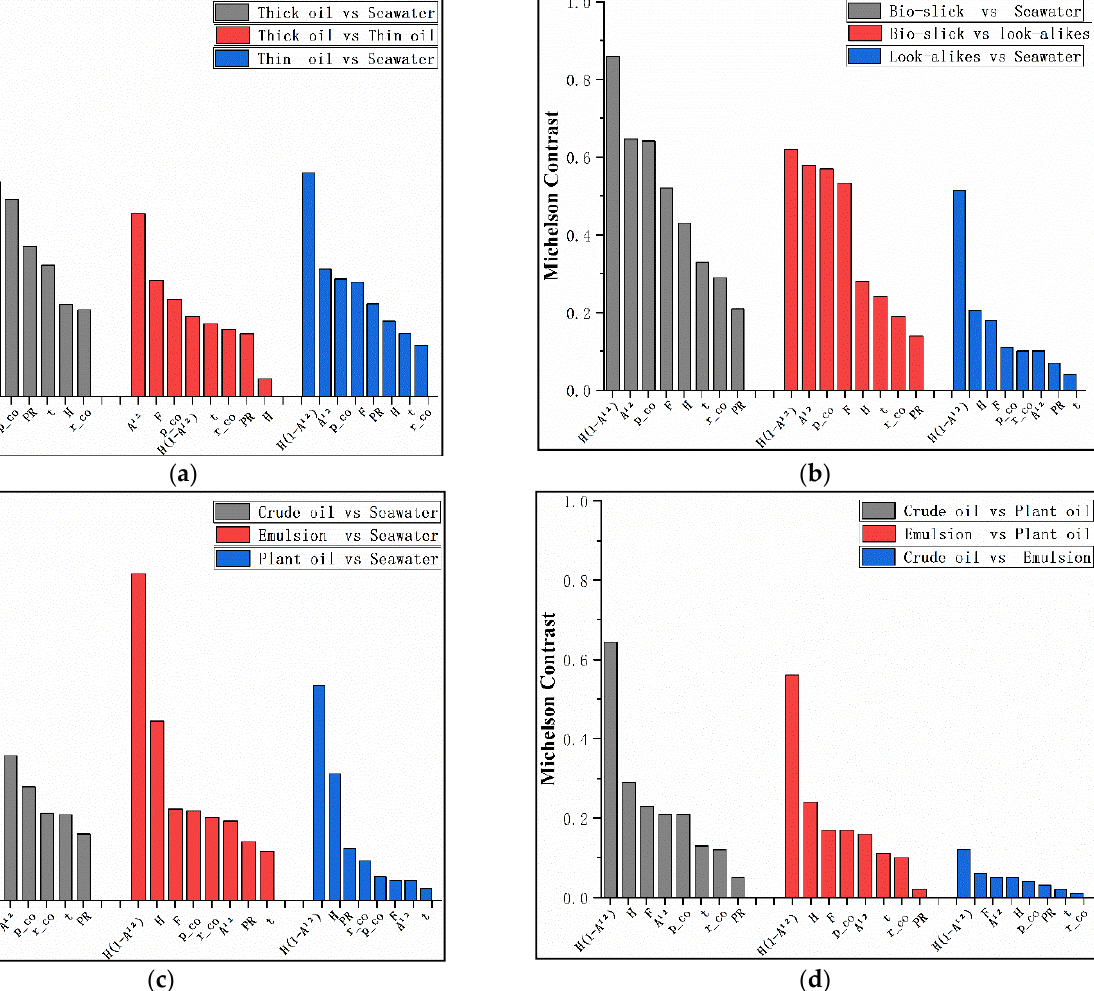
Figure 9. MC measurement results with respect to different types of polarimetric feature. ( a ) Relative thickness of oil slick. ( b ) Oil slick vs look-alikes. ( c ) Different types of oil slick versus seawater. ( d ) Different types of oil slick.